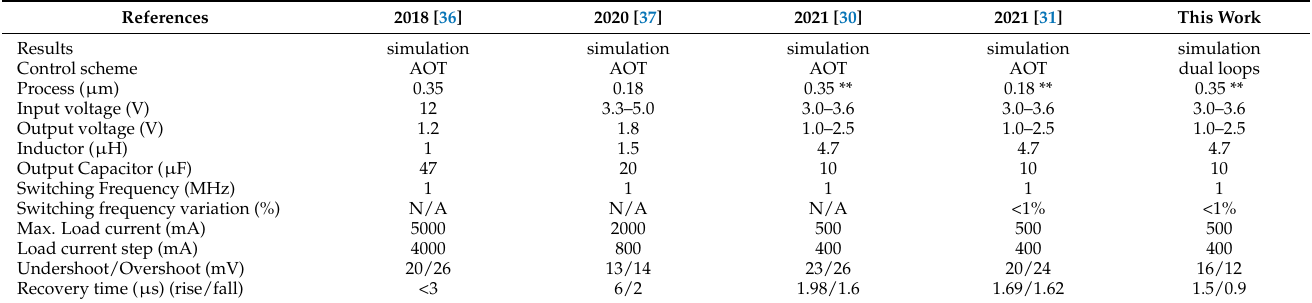
Table 3. Performance comparisons with reported